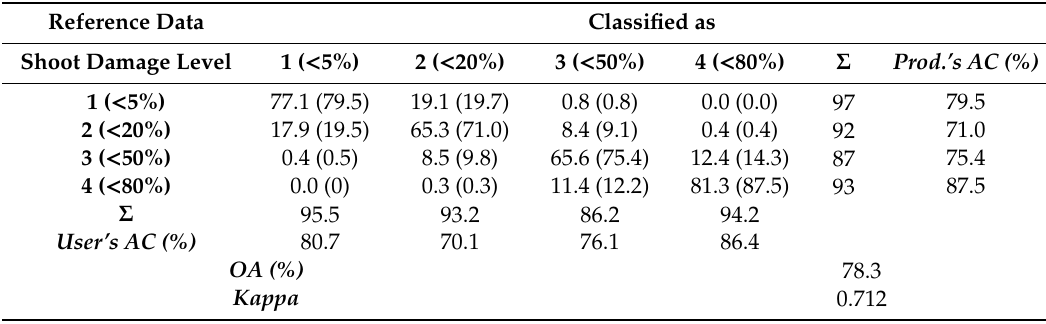
Table 3. Confusion matrix for level 1–4 classification with the overall accuracy, kappa, producer’s and user’s accuracy based on the stepwise linear discriminant analysis (SDA) classifier with all spectral variables. All values presented are means of a cross-validation of ten classifications.